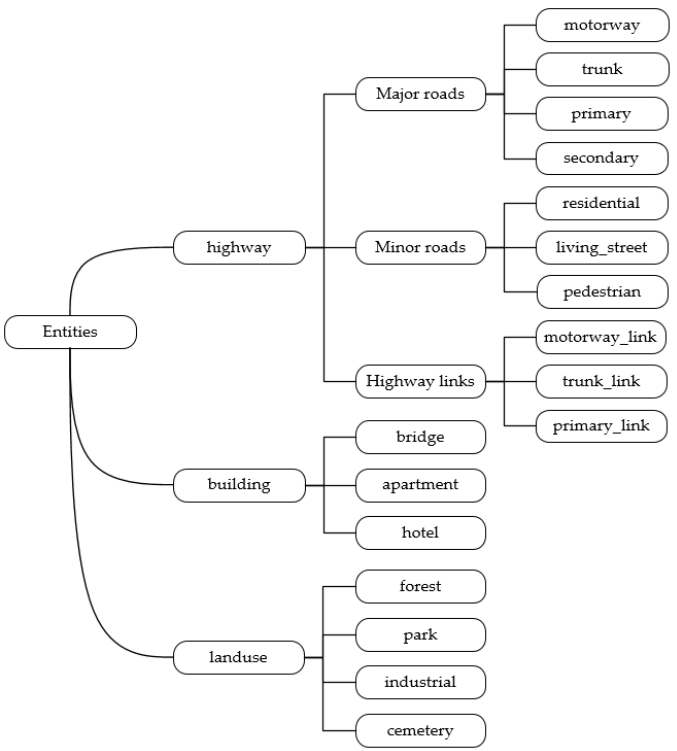
Figure 3. Part of volunteered geographic information ontology.